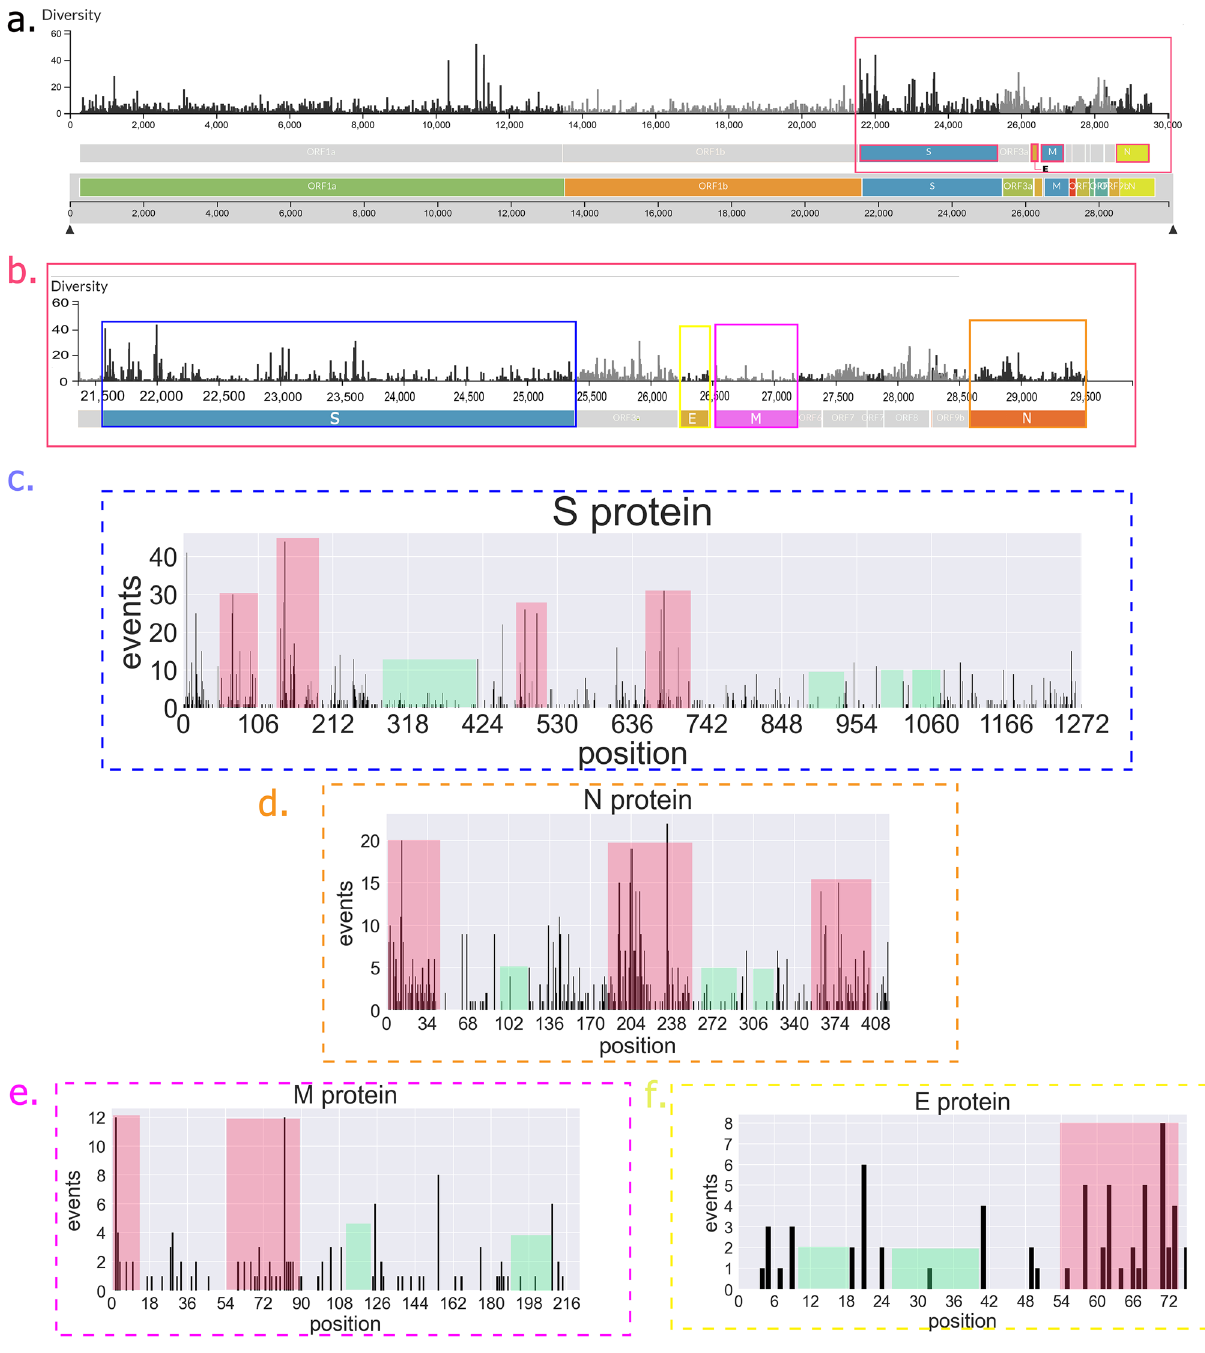
Figure 2. Mutations (events) in SARS-CoV-2 surface proteins (S, N, M, and E proteins) based on changes in their amino acid sequences. All events have been recorded on SARS-CoV-2 proteins illustrated in the first diagram (panel a ). We focused on 4 main surface protein changes (the red box, panel b ). In panel c (dash lined blue box), S protein events are illustrated. Qualitatively, we can see some red areas that have a higher number of mutations in their sequences (or high density of mutations), in comparison with green areas with the lower number of mutations in their sequences. All these changes and this qualitative view (red and green areas) are also presented for N, M, and E proteins in panels d, e, and f